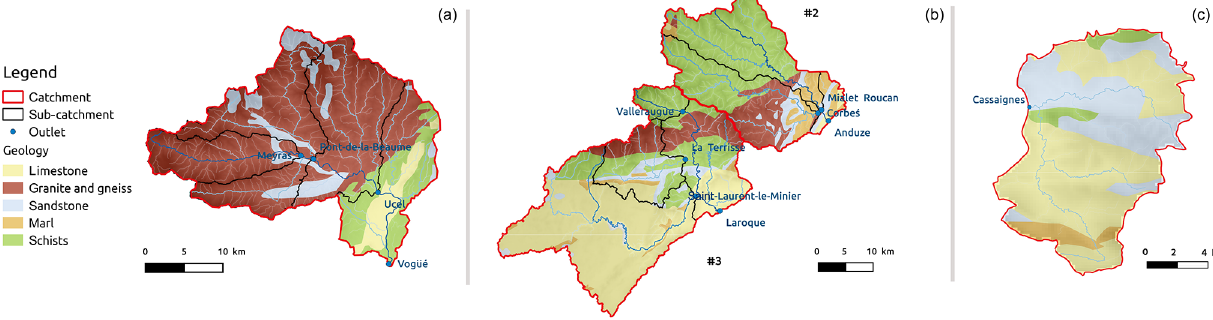
Figure 2. The geology of the Ardèche catchment (a) , the Gard and Hérault catchments (b) , and the Salz catchment (c) (sources: BD Million- Géol,